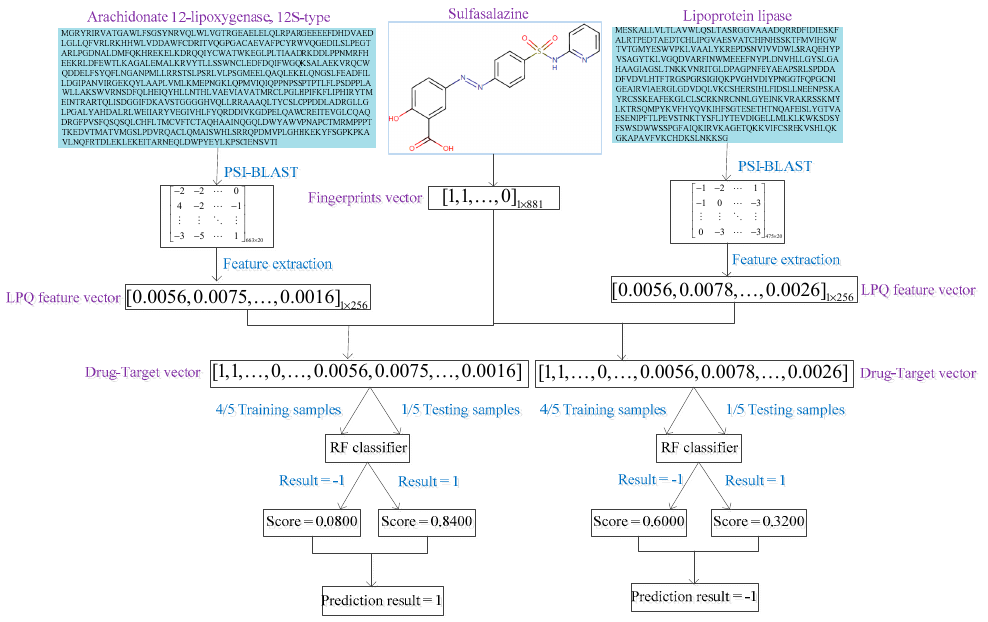
Figure 6. Flow chart for a given drug and target protein based on the proposed method.